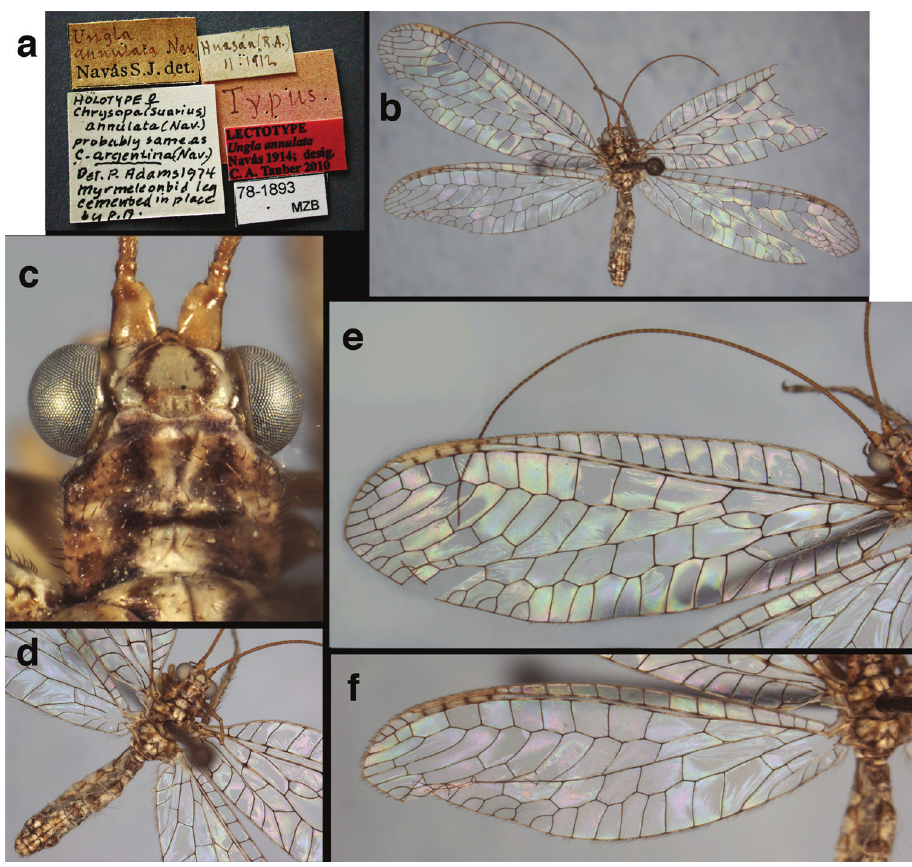
Figure 95. Ungla annulata Navás: External features, ( a ) labels ( b ) habitus, dorsal ( c ) head, dorsal ( d ) body, dorsal ( e ) forewing ( f ) hindwing (Argentina, Catamarca, lectotype, female, MZBS).